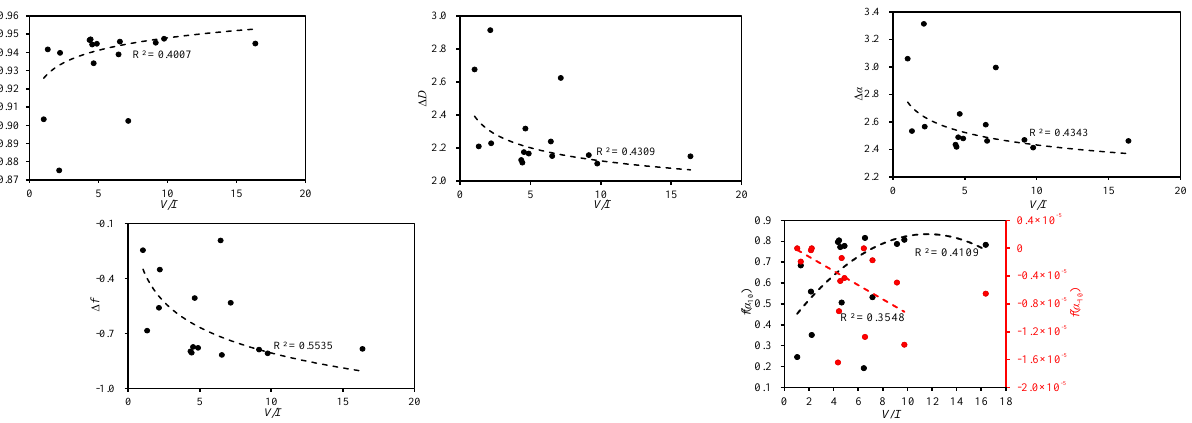
Figure 12. The relationships between multifractal parameters and vitrinite, inertinite and V/I.